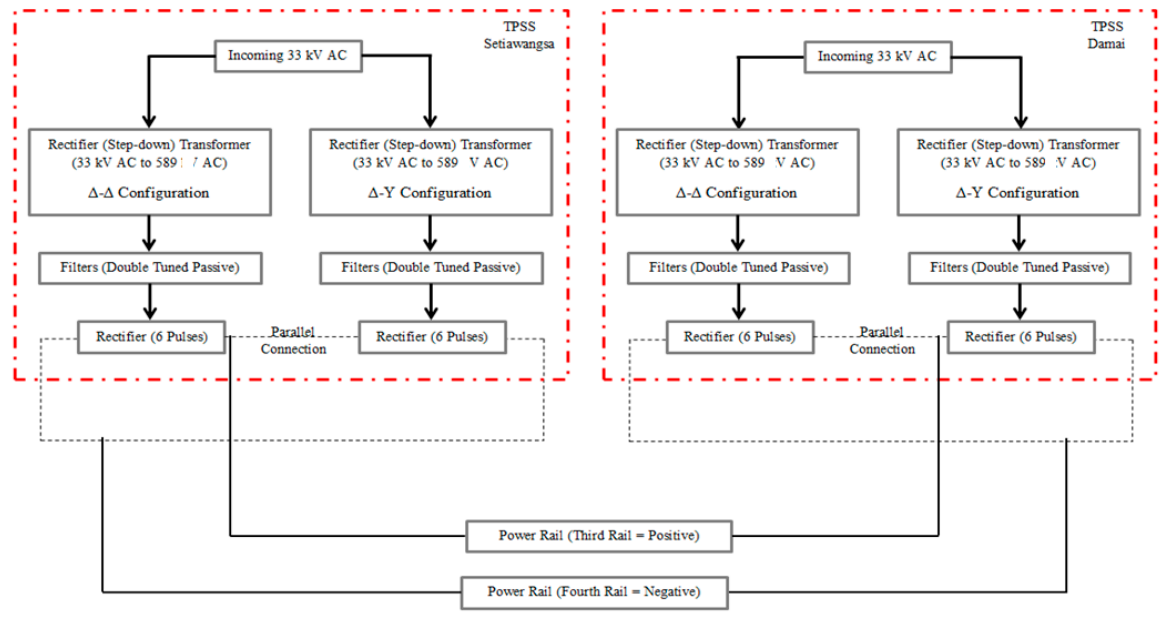
Figure 3. Block diagram of the LRT Kelana Jaya system.